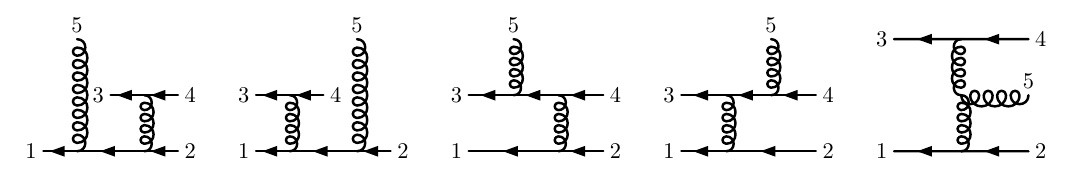
. Lines with arrows denote bifundamental 5 ; 2